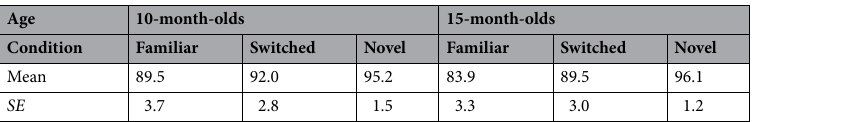
Table 2. Proportion of looking time (%) during the test